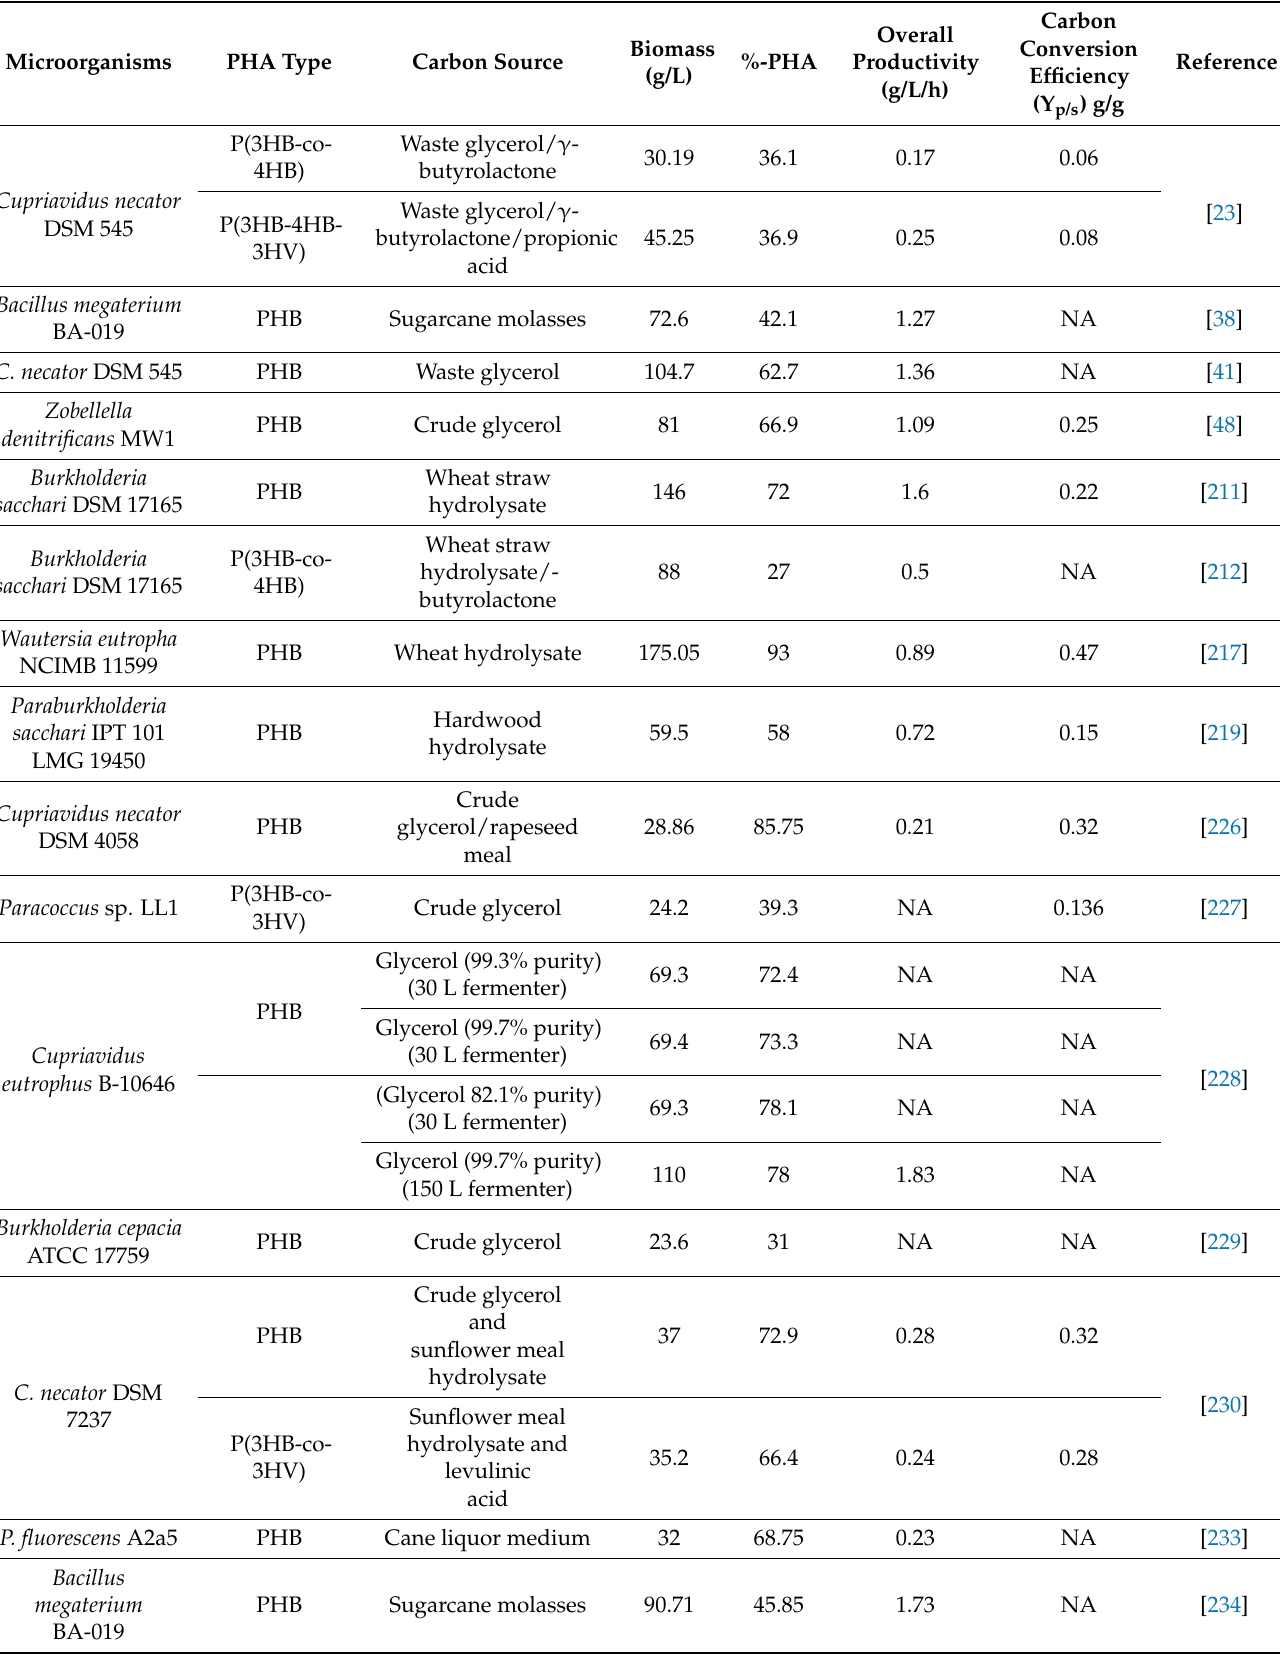
Table 6. Production of scl- and mcl-PHA using renewable